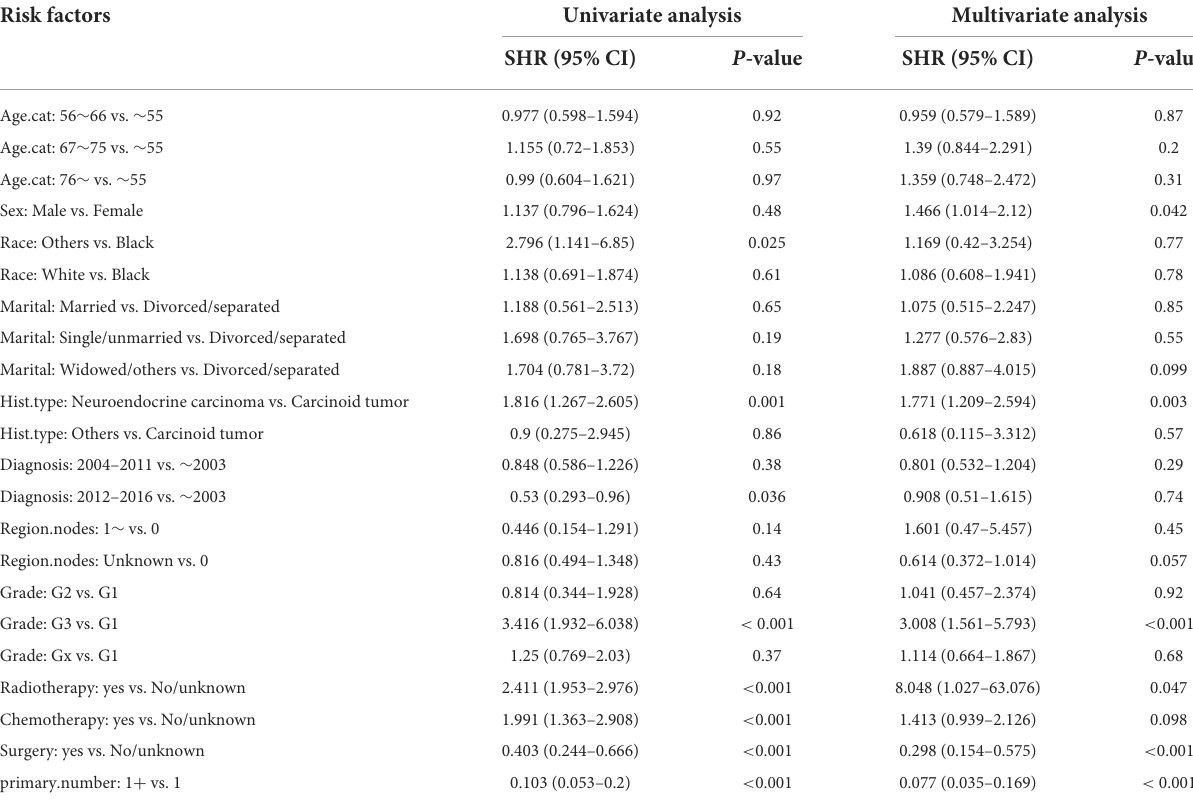
TABLE 5 Univariate and multivariate Fine-Gray analysis of factors for cumulative probabilities of PHNET-specific death in the validation set. Risk